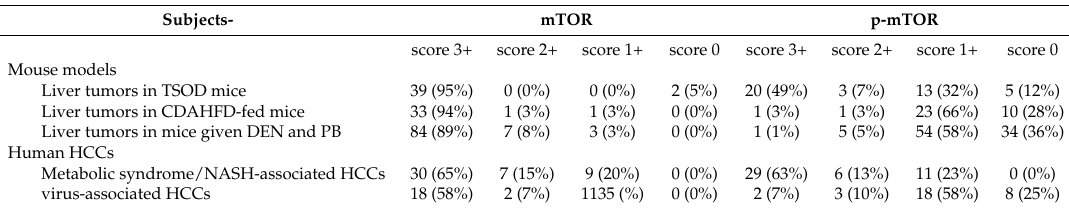
Table 6. Immunohistochemical findings for mTOR and p-mTOR in mouse model liver tumors and human